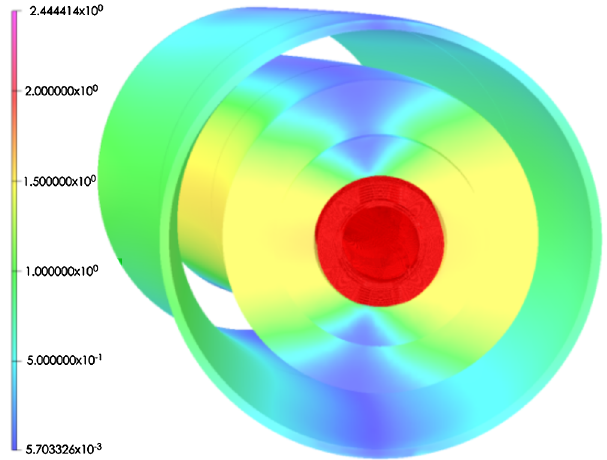
FIG. 8. Three-dimensional image of magnetic-flux density for the small-aperture magnet, as calculated by the three- dimensional electromagnetic field solver, OPERA-3D . The unit of the magnetic field, j B j , is T. In the calculation, coil currents of 136 and 130 A were applied for the dipole and quadrupole coils,